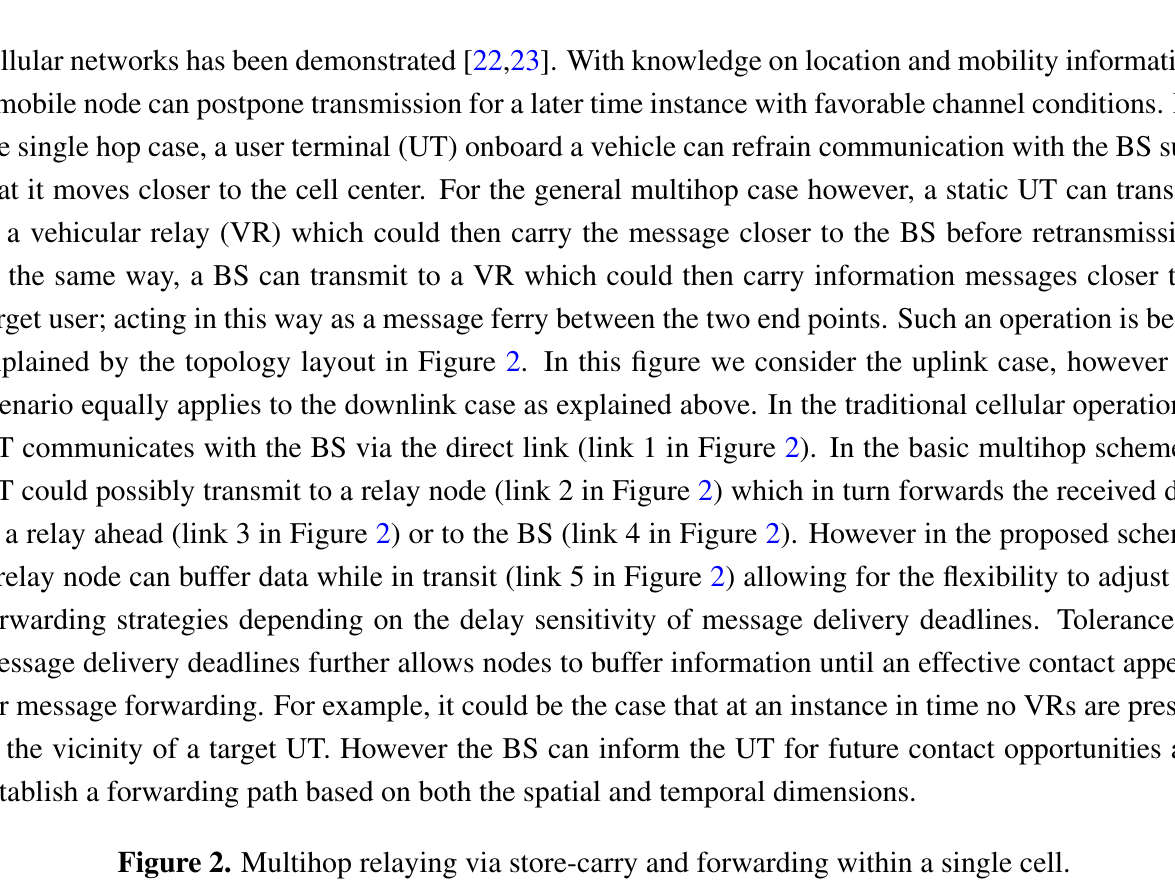
Figure 2. Multihop relaying via store-carry and forwarding within a single